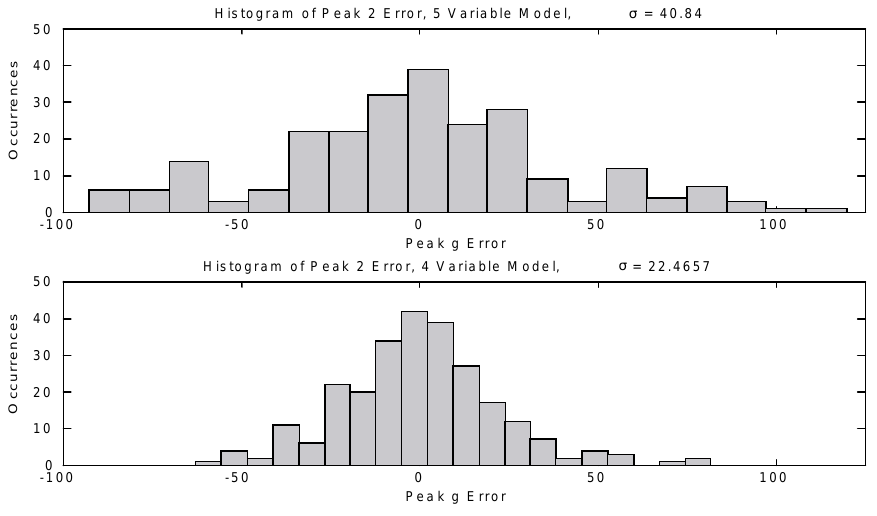
Fig. 10. Histograms of model error in peak acceleration prediction.